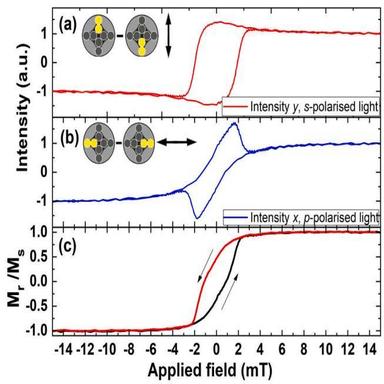
Hysteresis loops, obtained with complimentary sensitivities during the field sweep at an angle of 40◦ to the x-direction: (a) s-polarised light along the y-axis and (b) p-polarised light along the x-axis. In (c) the magnetisation along the field direction is plotted, reconstructed from (a) and (b).